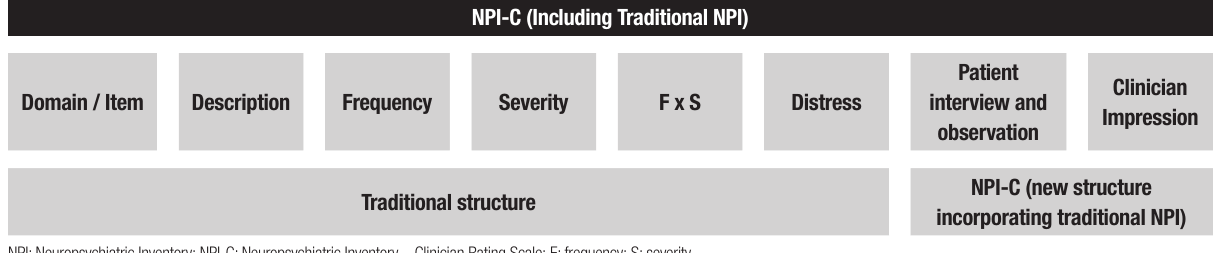
Figure 2. Structure of the Neuropsychiatric Inventory – Clinician Rating Scale